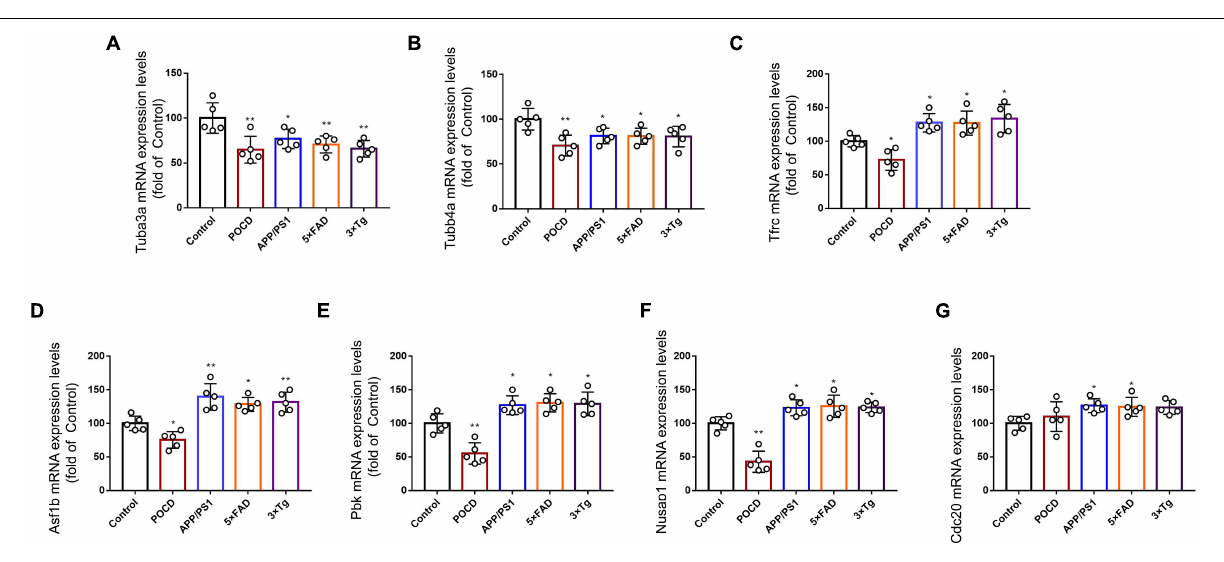
Frontiers in Aging Neuroscience |